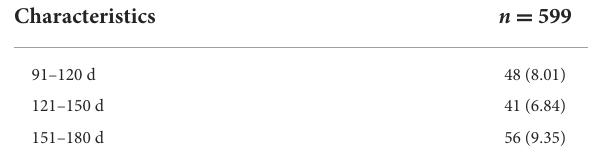
TABLE 1 Characteristics of patients with post-stroke SCC at